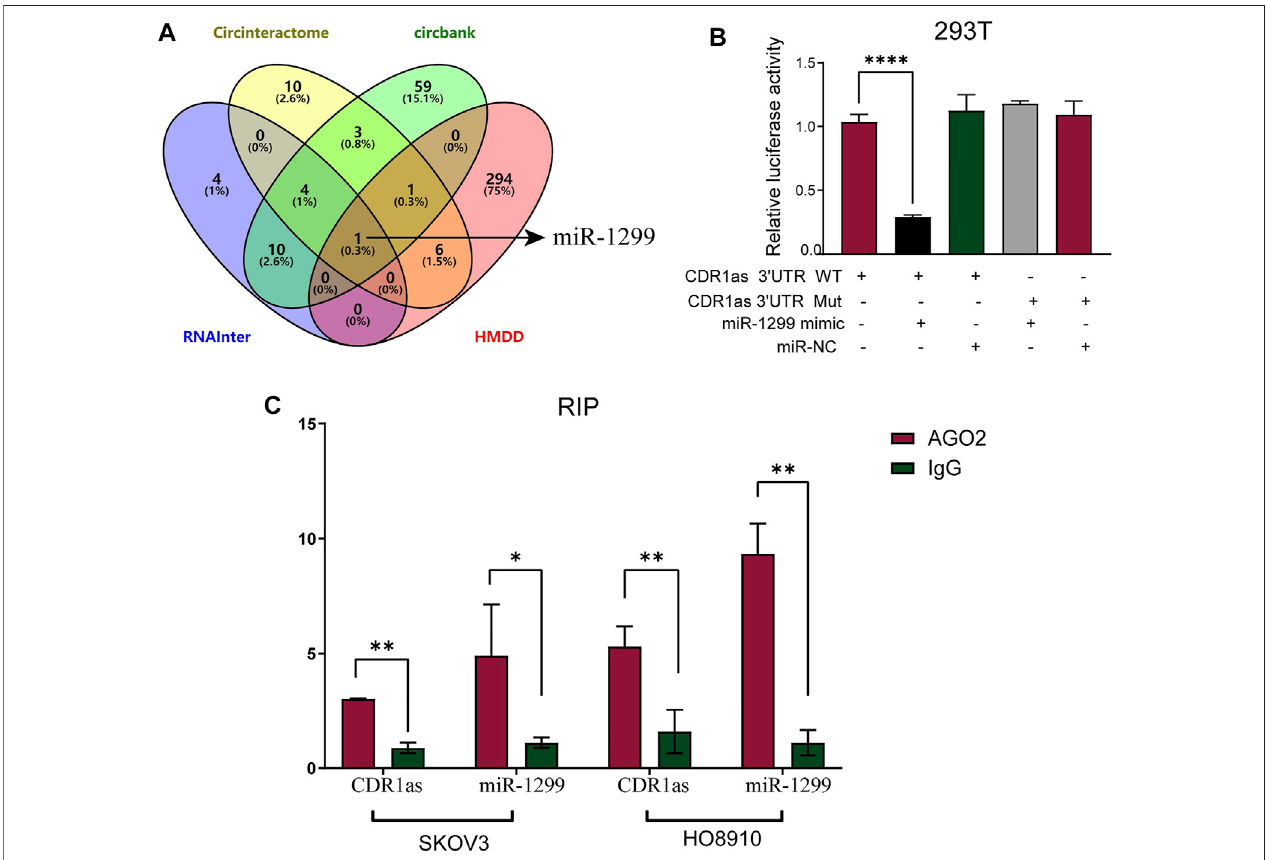
FIGURE 6 | CDR1as serves as a miRNA sponge of miR-1299. (A) RNAInter, CircInteraction, CircBank, and HMDD databases were used to predict the target miRNA of CDR1as. (B) The interaction between CDR1as and miR-1299 in 293T cells was veri fi ed using dual luciferase report assay. (C) RIP experiments enriched CDR1as and miR-1299 by qRT-PCR in OC cells. These results were presented as the mean ± SDs. ** p < 0.01 and **** p <